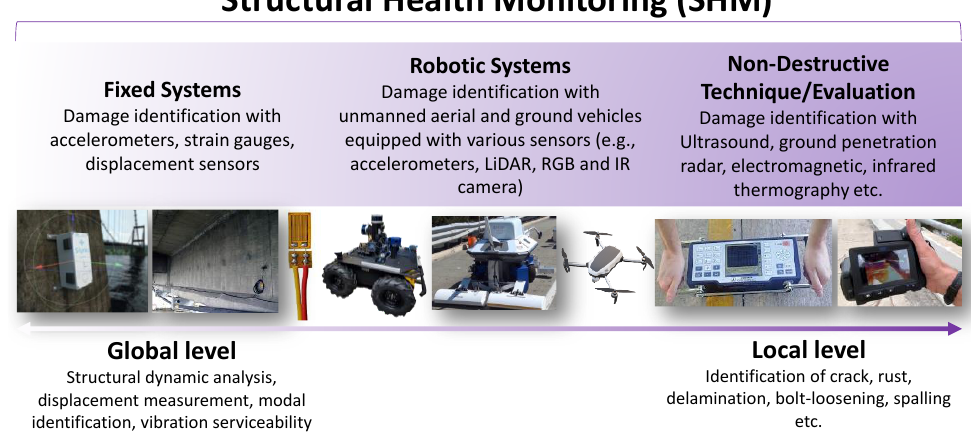
Figure 2. Global- and local-level SHM continuum.